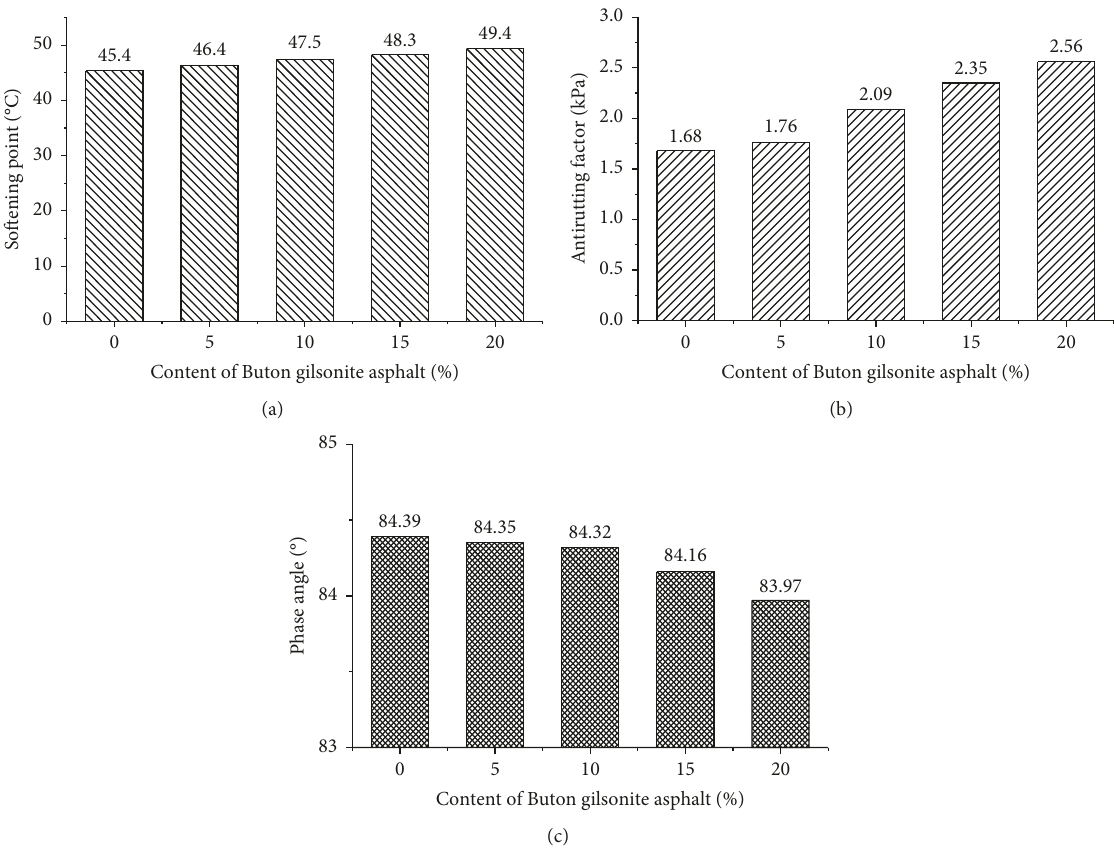
Figure 6: Comparison of high-temperature stability of modified asphalt with different gilsonite contents. (a) Softening point. (b) Antirutting factor. (c) Phase angle.